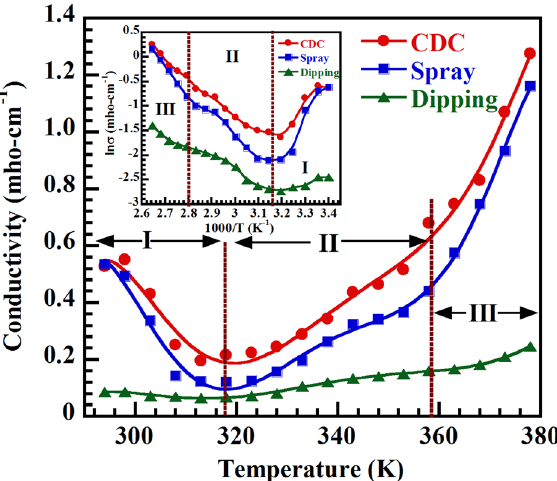
Figure 6. Electrical properties of CH 3 NH 3 PbI 3−x Cl x . Temperature dependent dc-electrical conductivity of CH 3 NH 3 PbI 3−x Cl x thin films showing three distinct regions. Inset shows the variation of lnσ with 1000/T graph for calculating activation